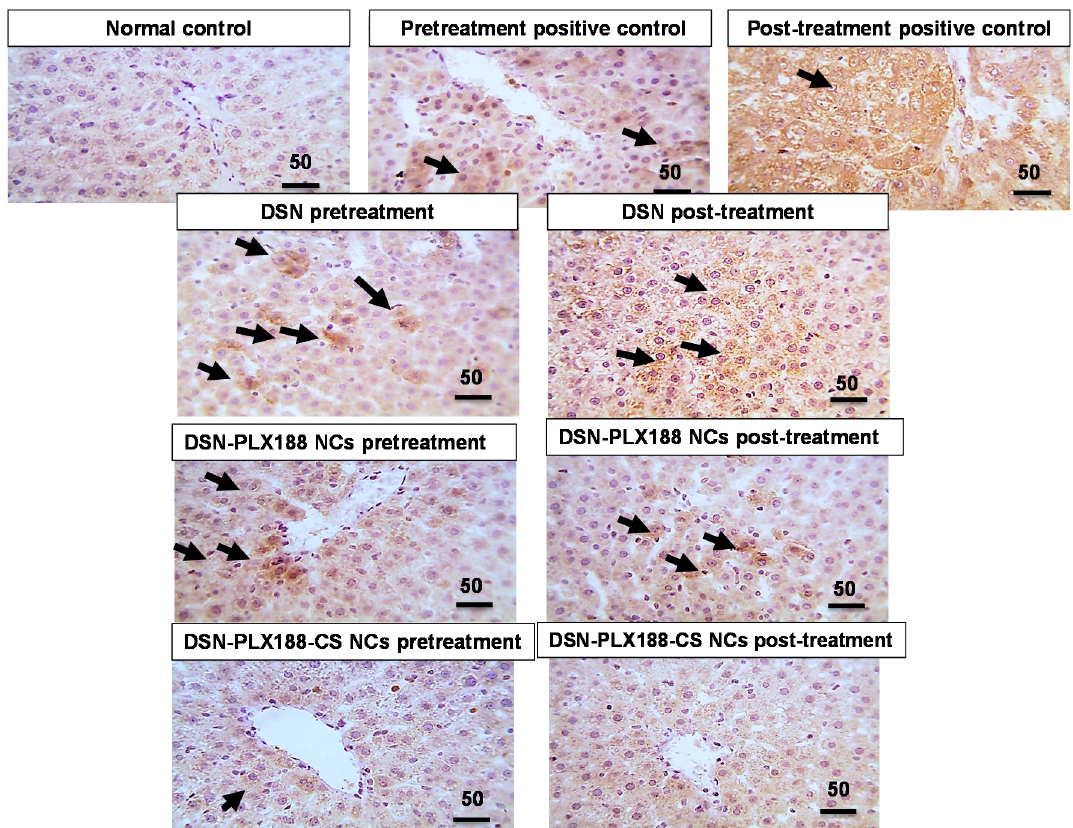
Figure 10. Microscopic pictures of immunostained hepatic sections against iNOS in the different groups following the pretreatment and the post-treatment regimens. High magnification x: 400 bar 50. Positive expression against iNOS (black arrow).